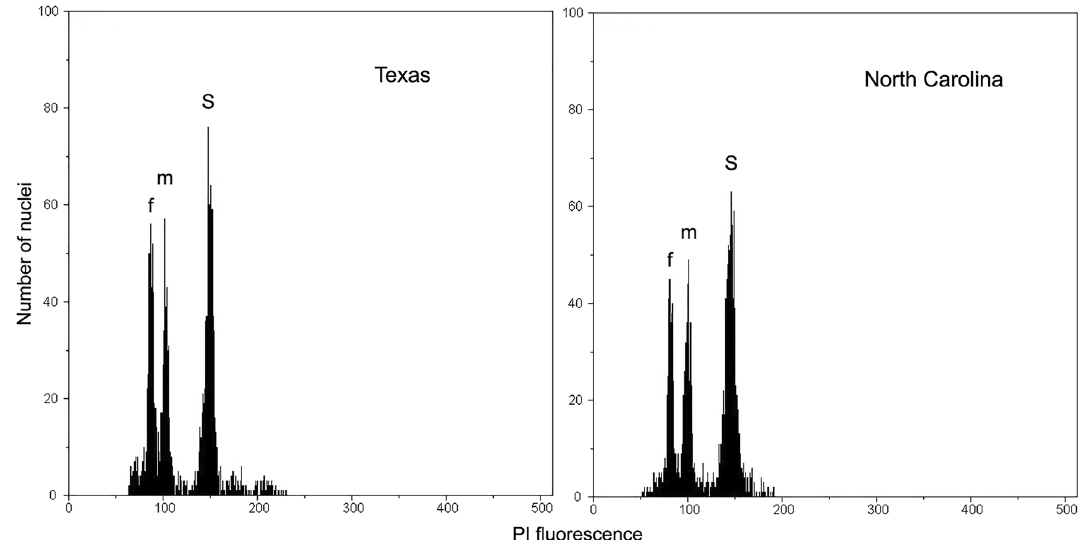
Figure 1. Selected FCM histograms of nuclear DNA content in PI-stained nuclei isolated from pollen grains of two races of Rumex hastatulus , Texas and North Carolina. f female nuclei, m male nuclei, S internal standard: Petunia hybrida , 2C = 2.85 pg.